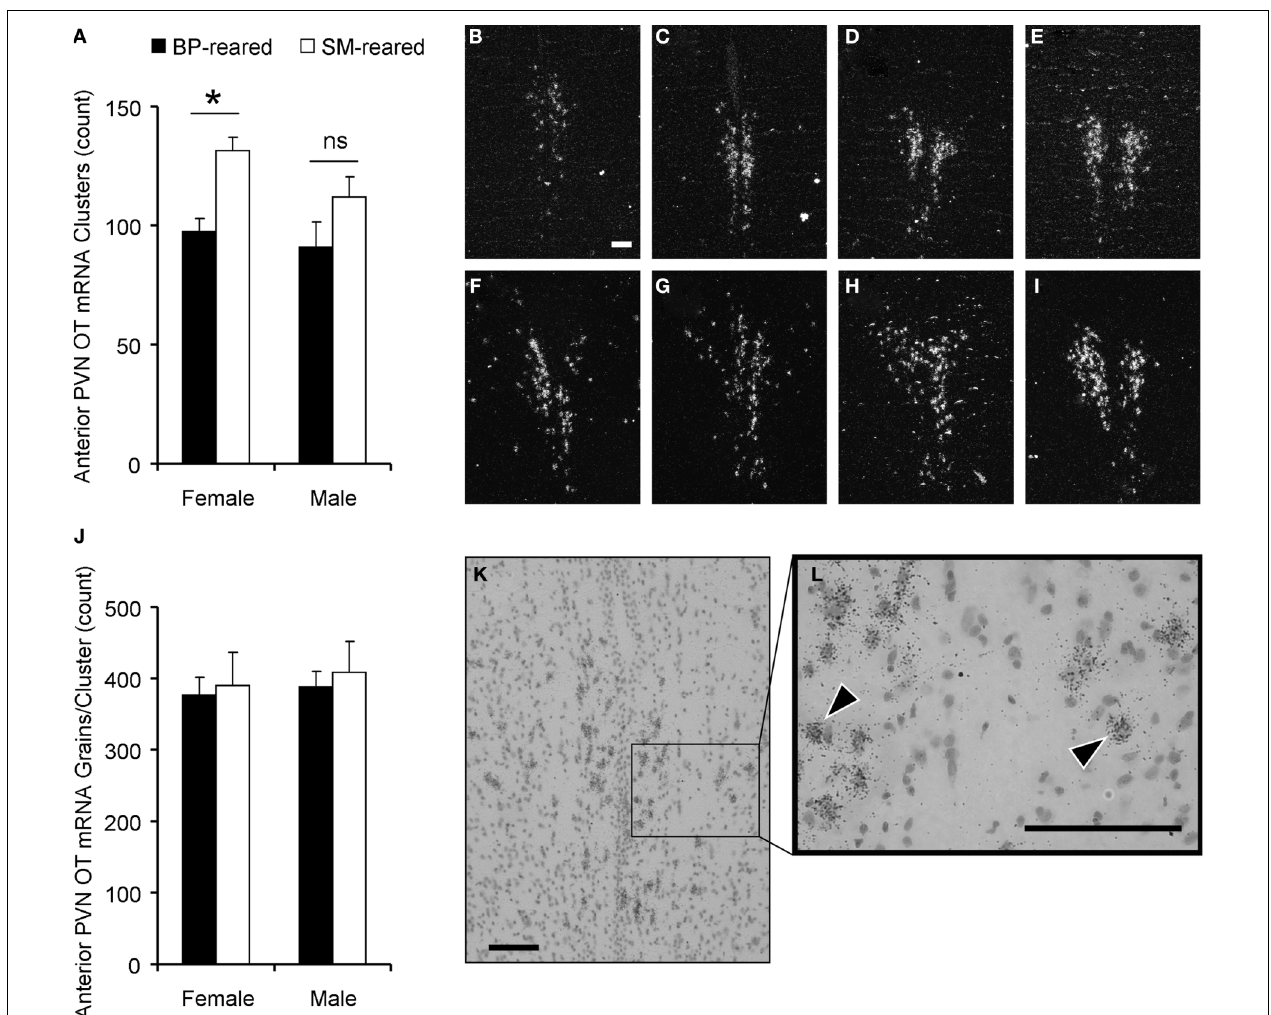
FIGURE 6 | Oxytocin content in the paraventricular nucleus of the hypothalamus (PVN). Brains were extracted from behaviorally-naïve SM- and BP-reared adults and analyzed for oxytocin (OT) mRNA expression using in situ hybridization and emulsion dipping. SM-reared animals had a signifi cantly greater number of OT mRNA grain clusters throughout the PVN, particularly in the anterior portion, compared to BP-reared animals (A) . Representative, anterior to posterior, coronal, 10 × images of the PVN of SM- (B–E) and BP- (F–I)